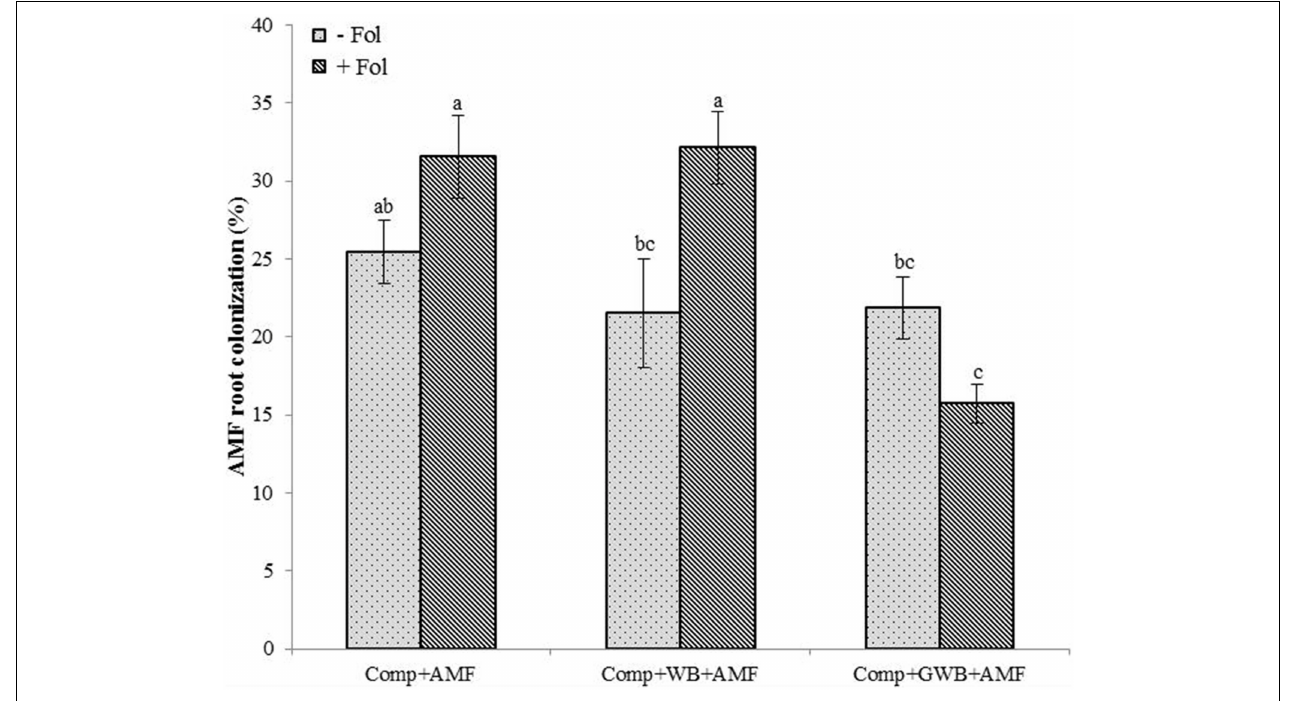
FIGURE 3 | Effect of different soil substrate compositions comprising of compost (Comp), and combination of compost with WB (Comp + WB) and with GWB (Comp + GWB), un-inoculated ( − Fol) and